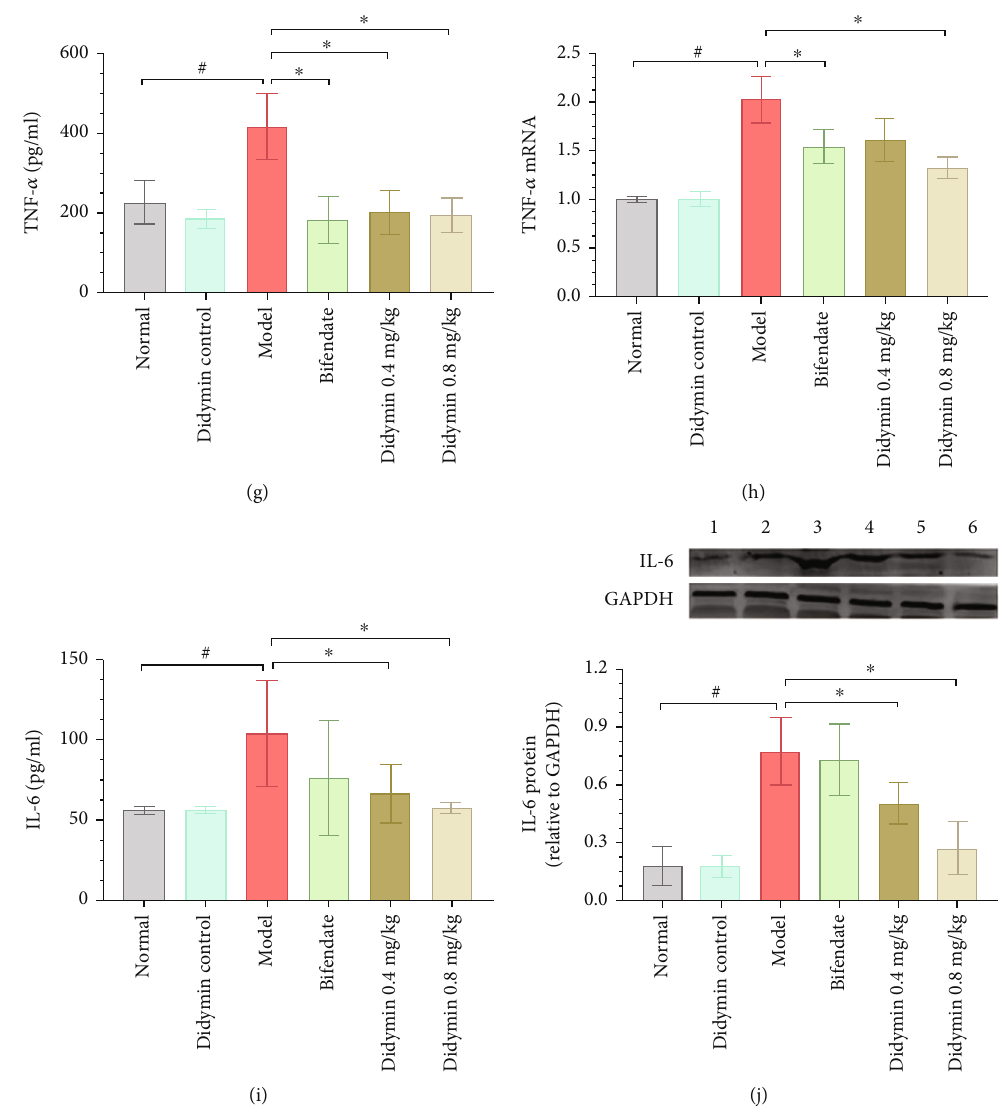
Figure 3: Didymin alleviated oxidative damage and in fl ammatory response in LPS/D-Gal-induced ALI. (a – e) The activities of GSH-Rd, SOD, ROS, MDA, and iNOS were detected by commercially available kits. (f – h) The concentrations of IL-1 β , TNF- α , and IL-6 were determined by enzyme-linked immunosorbent assay. (i) The mRNA expression level of TNF- α was detected by RT-PCR assays. (j) The expression of IL-6 was determined using western blot. Bands 1 to 6, respectively, represent the normal control group, didymin control group, model group, bifendate-treated group, and low- and high-dosages of didymin-treated groups. The data are presented as mean ± SD . # P < 0 : 05 vs. the normal group; ∗ P < 0 : 05 vs. the model